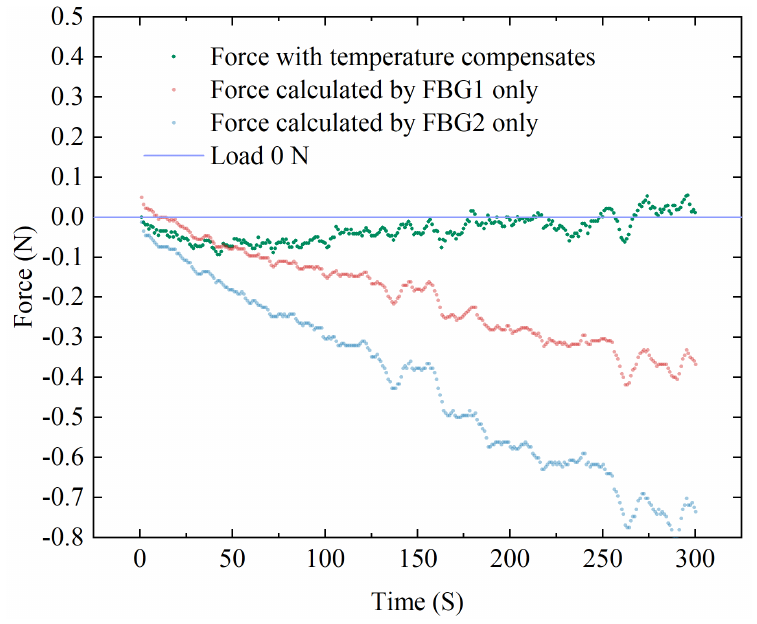
Figure 12. Temperature compensation experiment data of FBG